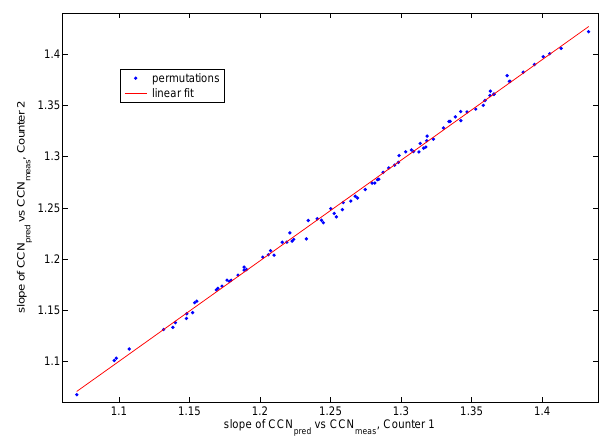
Fig. 6. The comparison of the permutation results of the first and the second CCN counter for 0.20% SS and 0.22% SS , respectively. The slope of the linear fit was 0 . 98, thus represents a very good correlation.